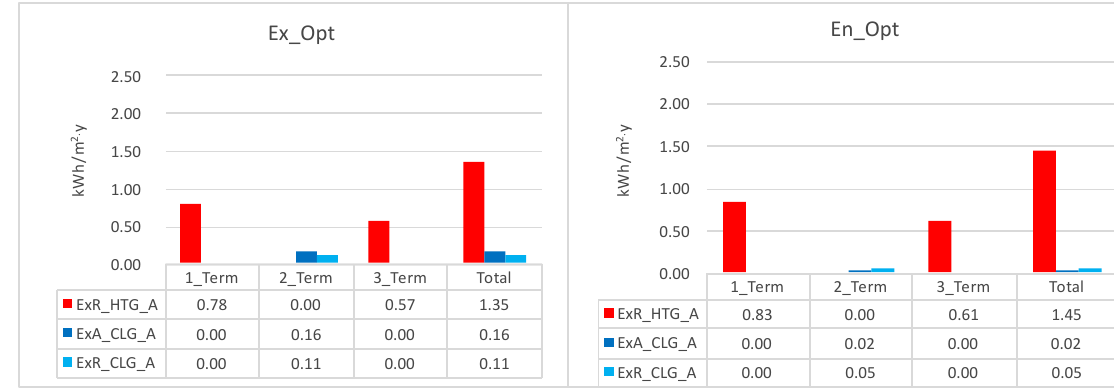
Figure 12. Exergy analysis in the air environment.